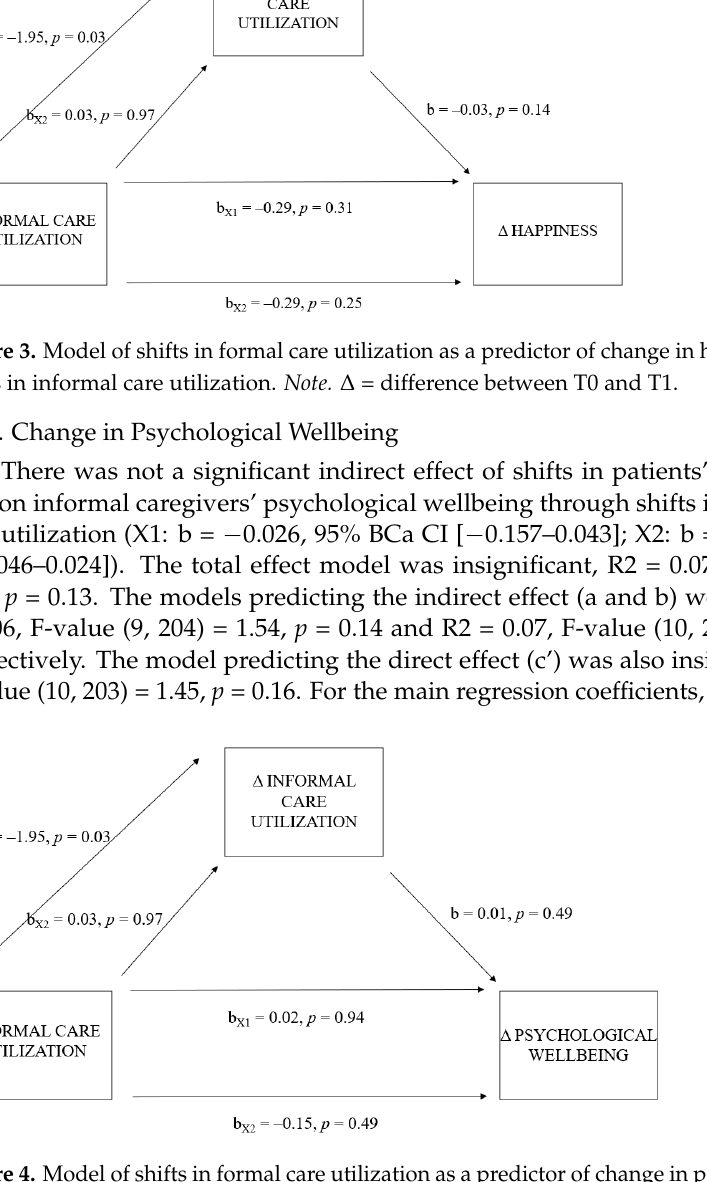
Figure 4. Model of shifts in formal care utilization as a predictor of change in psychological wellbeing, mediated by shifts in informal care utilization. Note. Δ = difference between T0 and T1 .